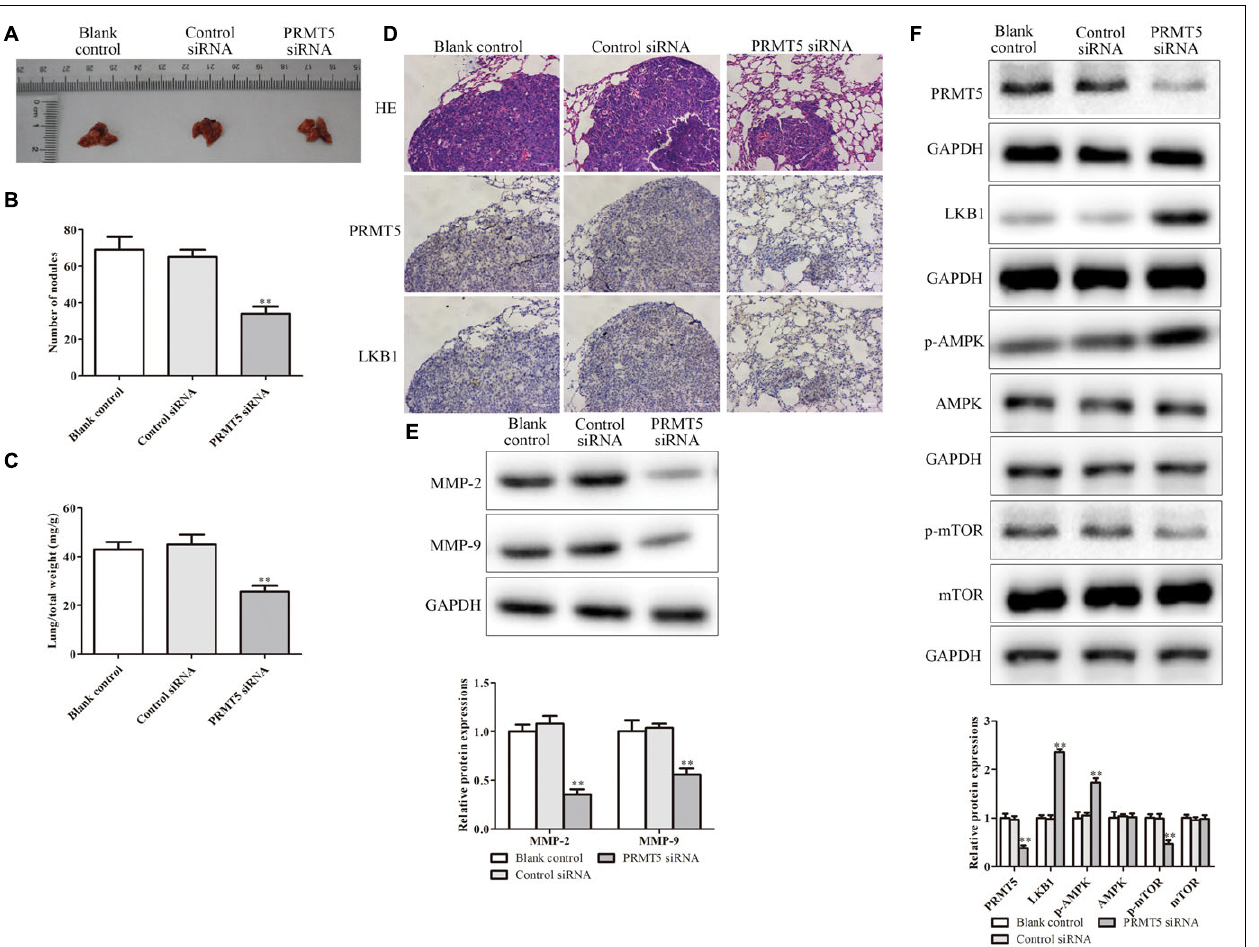
FIGURE 9 | PRMT5 promoted lung metastasis in vivo via LKB1/AMPK/mTOR signaling pathway. The transfected KYSE150 cells were injected into the mice tail vein. (A) Lung tissues with metastatic foci were shown. (B,C) The number of nodules and lung/total weight were measured in different groups. (D) Immunohistochemistry indicated the expression of PRMT5 was lower, while LKB1 expression was higher in mice injected with KYSE150 cells transfected with siRNA PRMT5. The photographs were taken at the magnification of × 200. (E) The expression levels of MMP-2 and MMP-9 were detected by western blotting. (F) The expression levels of PRMT5, LKB1, AMPK, p-AMPK, mTOR, and p-mTOR were analyzed in ESCC cell lines. GAPDH was used as a control. Bars indicate the mean ± SEM, * P < 0.05, ** P < 0.01 vs. control siRNA. PRMT5, protein arginine methyltransferase 5; LKB1, liver kinase B1; AMPK, adenosine monophosphate kinase;